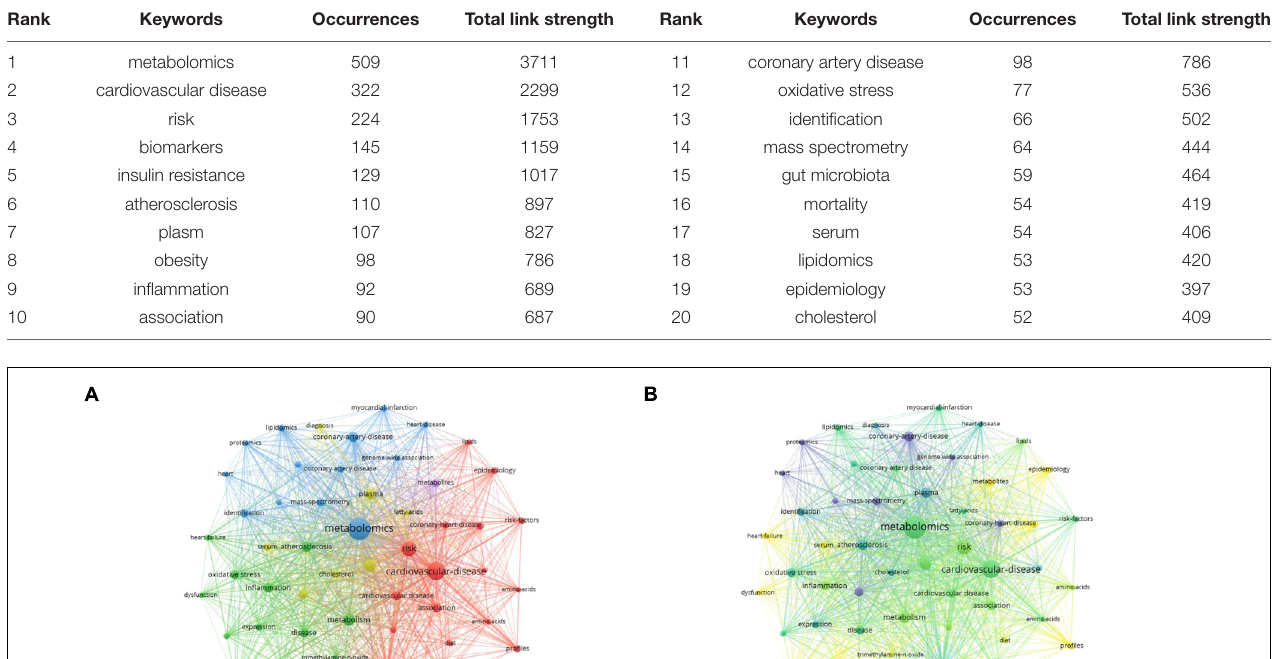
TABLE 6 | Top 20 keywords with the most occurrences and total link strength.